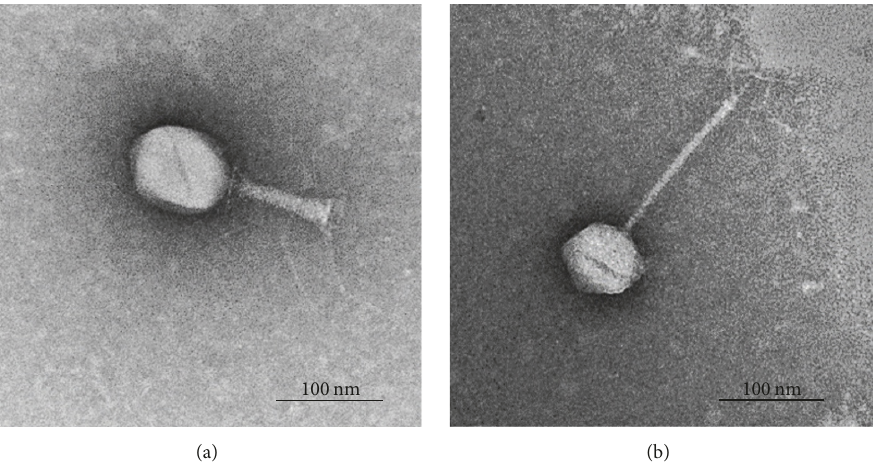
Figure 2: Transmission electron micrograph of phages P-1, P-2, and P-5 belonging to Myoviridae family (a), and P-3, P-4, P-6, and P-7 categorized as Siphoviridae family (b). Scale bar represents